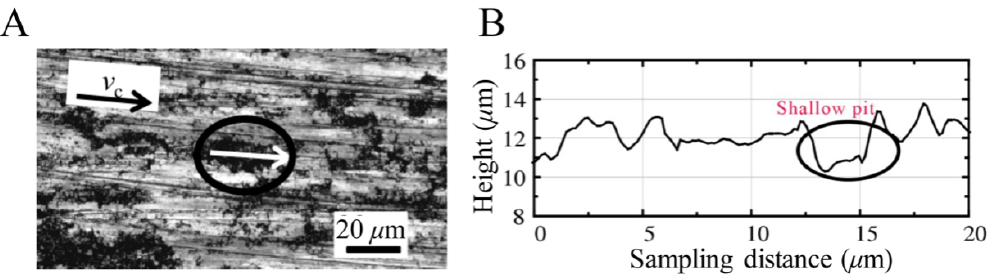
21 of 26 Figure 20. ( A – D ) Schematic diagram of the shallow pit formation process. As shown in Figure 21, the accuracy of the simulation results was verified by com- paring the results of the existing processing experiments, the surface morphology of the SiCp/Al composite was observed with a laser confocal microscope after milling was com-